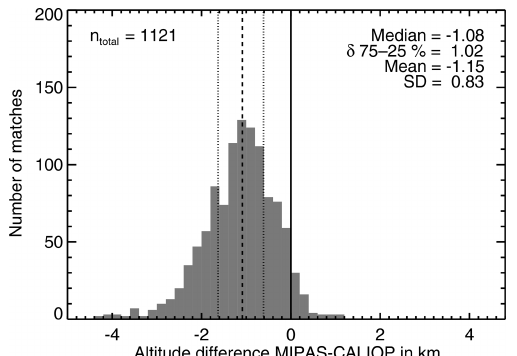
Figure 8. Distribution of cloud top height differences (MIPAS– CALIOP) for aerosol measurements of the Nabro sulfate aerosol in June, July, and August 2011. The cloud top height from CALIOP was derived using an altitude-variable extinction threshold that is 3 × 10 − 3 km − 1 at 18km. The black dashed line indicates the me- dian, the dotted lines are the 25th and 75th percentiles, and the solid line marks the zero